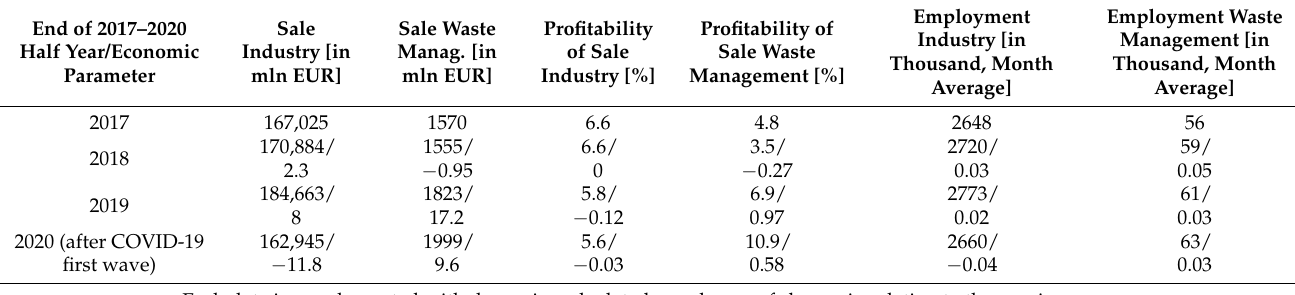
Table 2. Economic indicators of waste management industry in Poland under first wave of the COVID-19 pandemic, in comparison with the entire industry; results after the first half of 2020 in light of the same date’s previous three